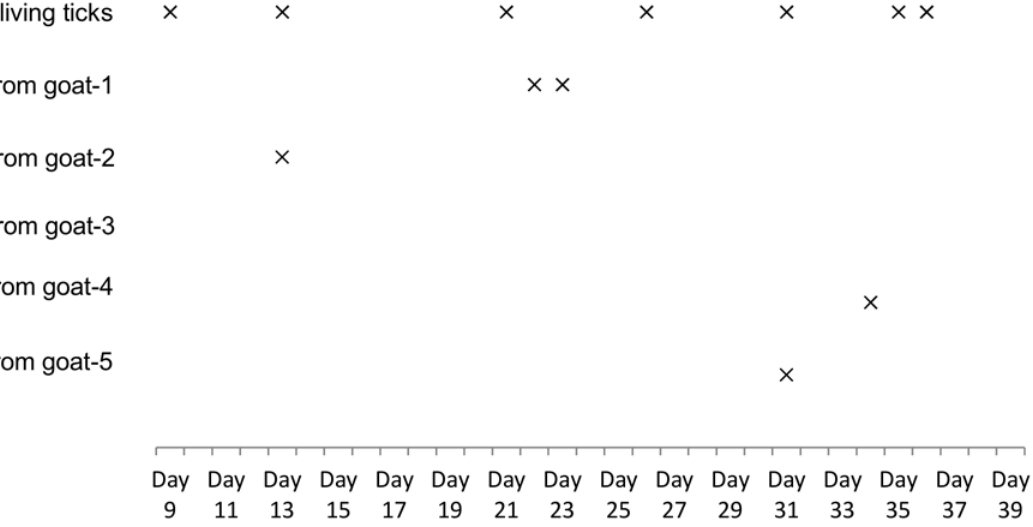
Fig 5. SFTSV RNA detection from H . longicornis ticks in natural infection study. The free-living and parasitic tick samples were collected from natural environment and animal cohort including 5 goats (called from goat-1, -2, -3, -4, -5), respectively, during the period Day 0-Day 39. All the samples were subjected to SFTSV RNA detection as described in Materials and Methods. × RNA detected from tick